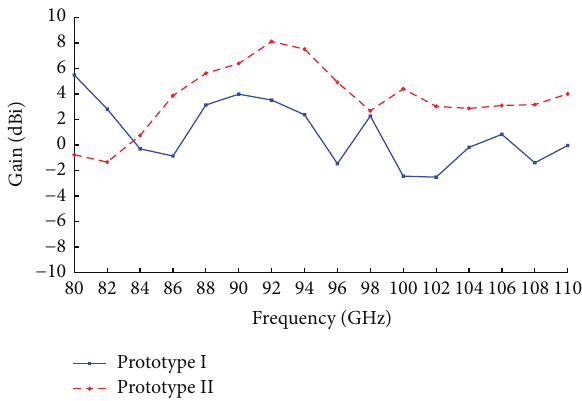
Figure 10: Simulated peak-realized gain versus frequency of the proposed Quasi-Yagi antenna prototypes I and